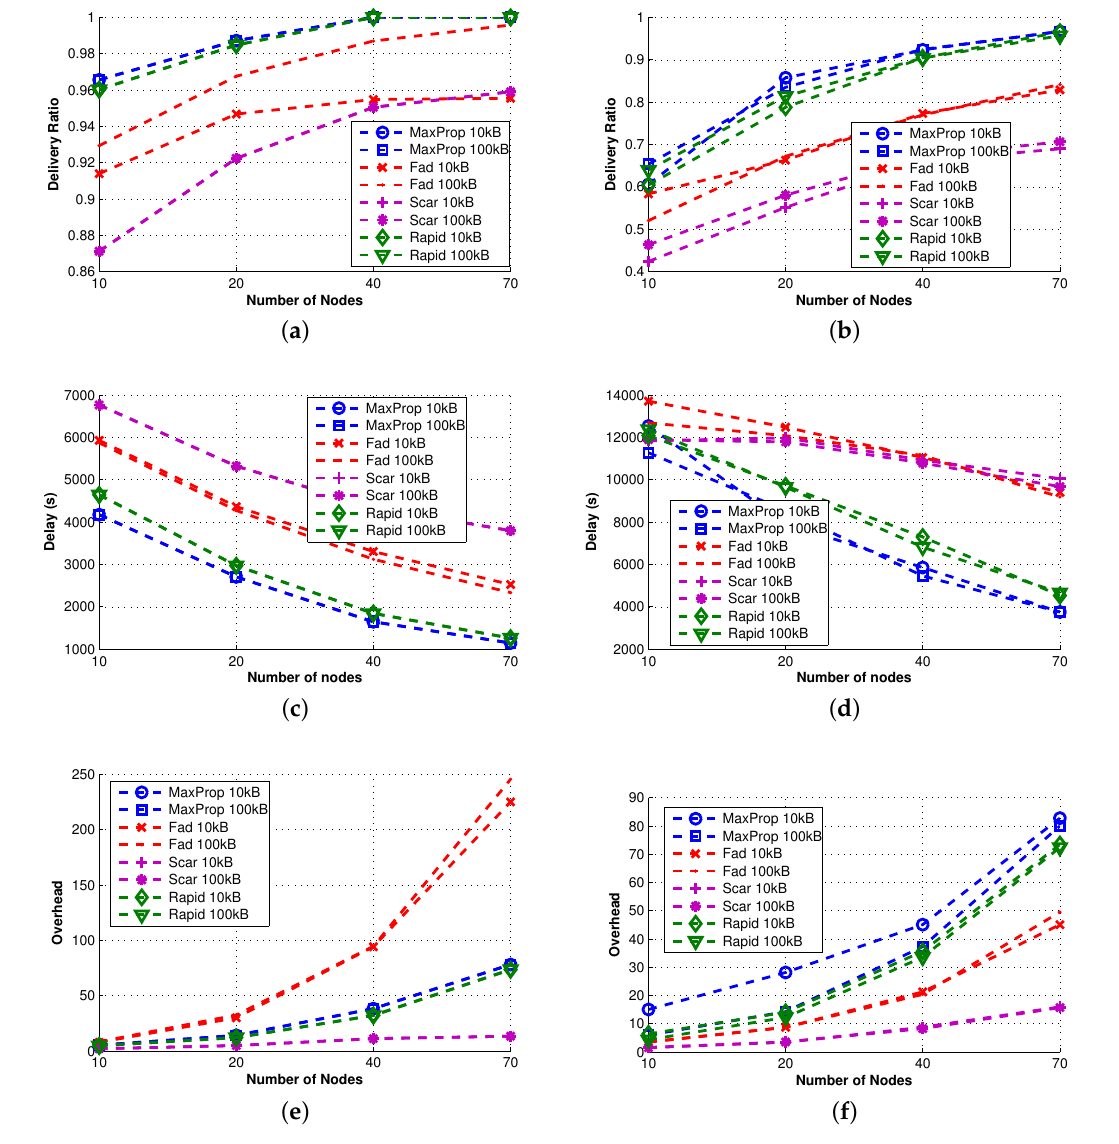
Figure 4. Synthetic traces. Random walk ( a , c , e ); Levy Walk ( b , d , f ). Advanced